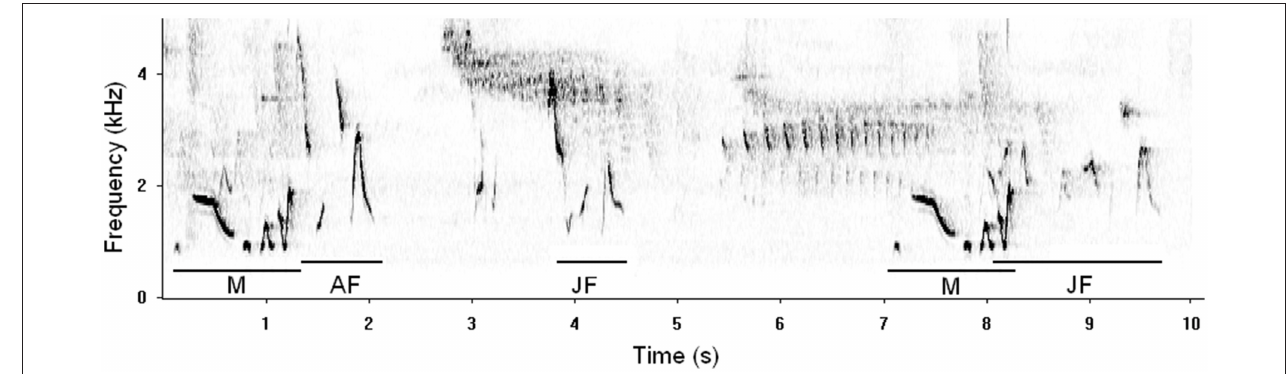
FIGURE 2 | A spectrogram of a field observation that may depict duet code learning. A duet between an adult male (M) and adult female (AF) begins at 0s. At 4s the pair’s juvenile daughter (JF) approximates the adult female’s song. After the male repeats his song at 7s, the daughter duets with him, again approximating the mother’s answer. Spectrograph drawn from a field recording by D.M.L (Gamboa, Republic of Panamá,